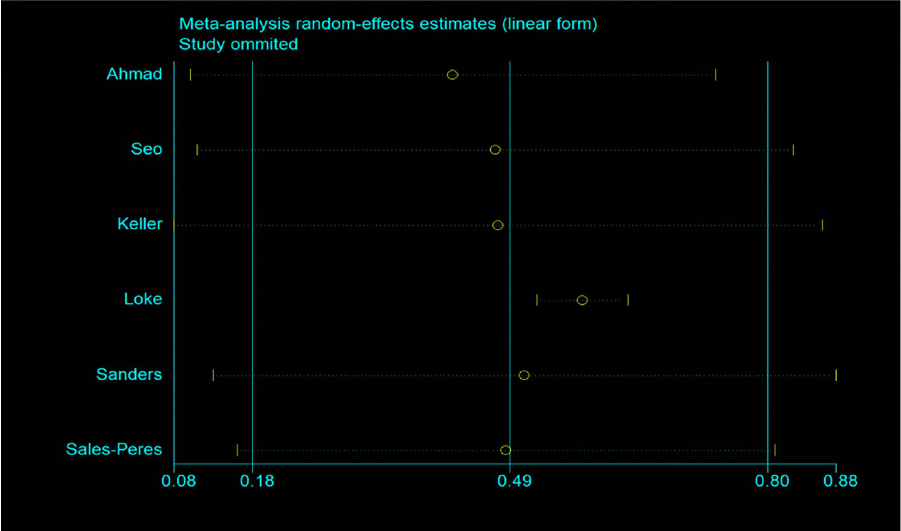
Fig 6. Plot of sensitivity analysis by excluding one study each time and the pooling estimate for the rest of the studies (for OSA and the risk of all-cause